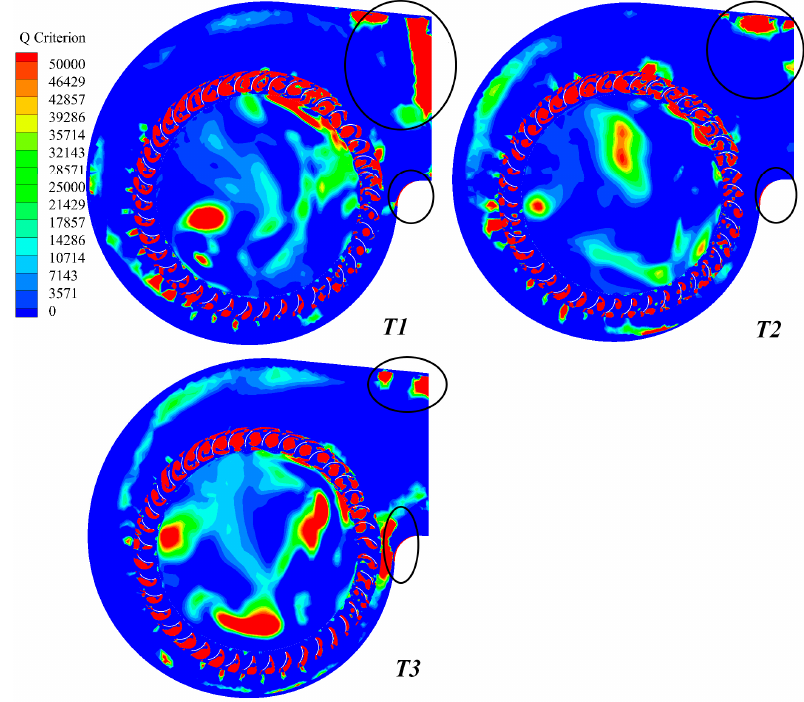
Figure 19. Q value distribution with time evolution at the Z = 0.015 m section (Q/Qn = 0.031). In order to further explain the internal flow physical essence of a centrifugal fan, the Q value distribution of the blade passage is presented with evolution at di ff erent times on the Z = 0.015 m section in Figure 20. As shown in Figure 20, it is clearly seen that the Q value is higher near the suction surface and at the end of the blade. When airflow flows through the blade passage, the flow pattern around the blade is complex. The separate flow appears near the suction surface, and an obvious eddy current exists at the tail of some blades, whereas the flow pattern around the blade wake is disordered. For the local enlarged image, the boundary layer separation occurs near the suction surface in the blade passage, and the Q value is obviously becomes high at T 3 . With the impeller rotating, the suction surface airflow separation cluster will fall o ff at the end of the blade. At the time of T1, the eddy current is not obvious at the end of the blade, and with the fan running, the eddy at the end of the blade will gradually become obvious, and the area will increase. The boundary layer separation on the suction surface and the shedding vortices at the end of the blade will lead to the pulsating reaction in the flow passage of